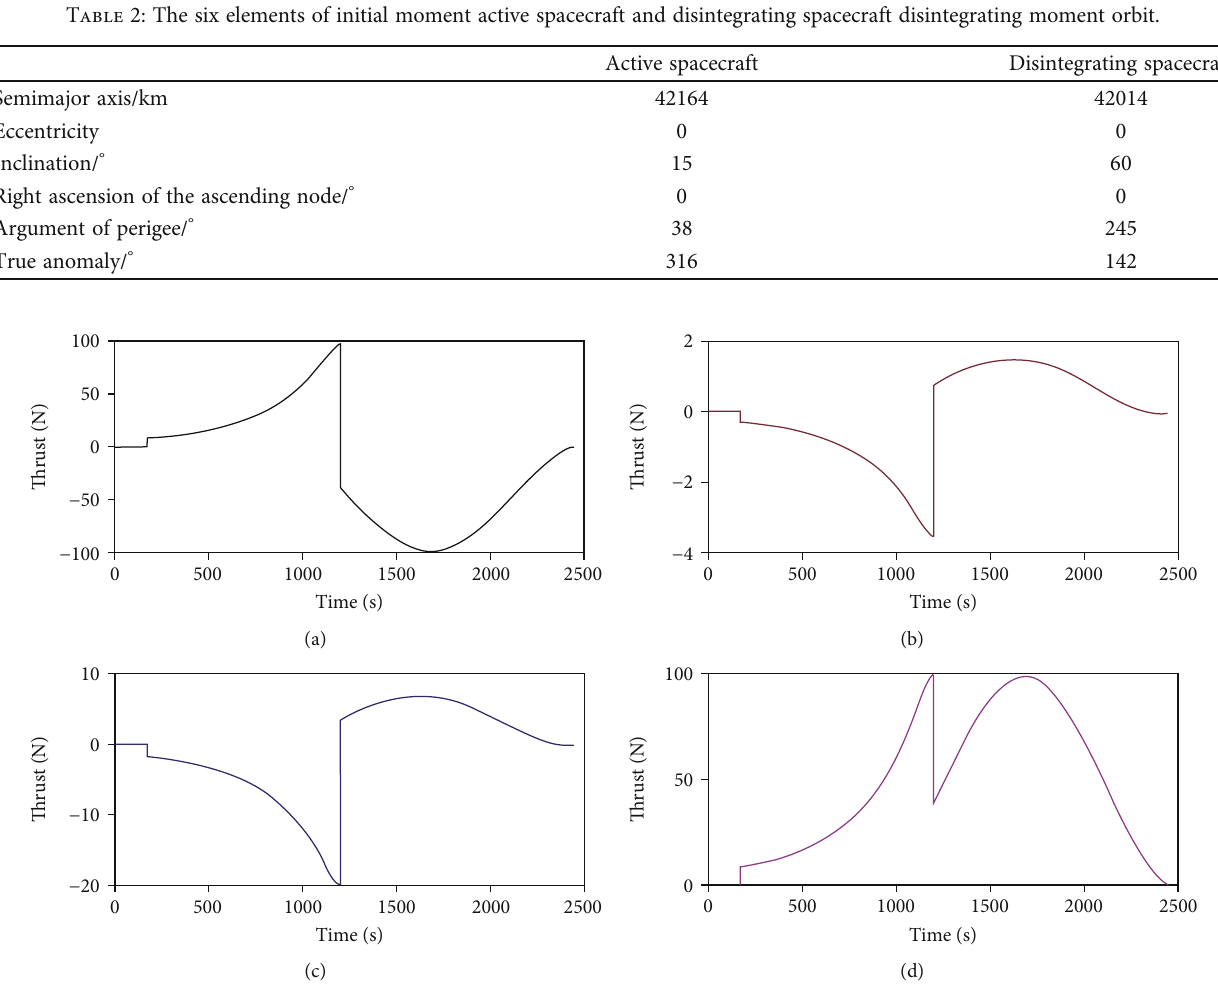
Figure 7: The thrust of the active spacecraft at the stage of avoidance and the stage of returning from the distant proximity: (a) thrust in the X direction, (b) thrust in the Y direction, (c) thrust in the Z direction, and (d) total thrust